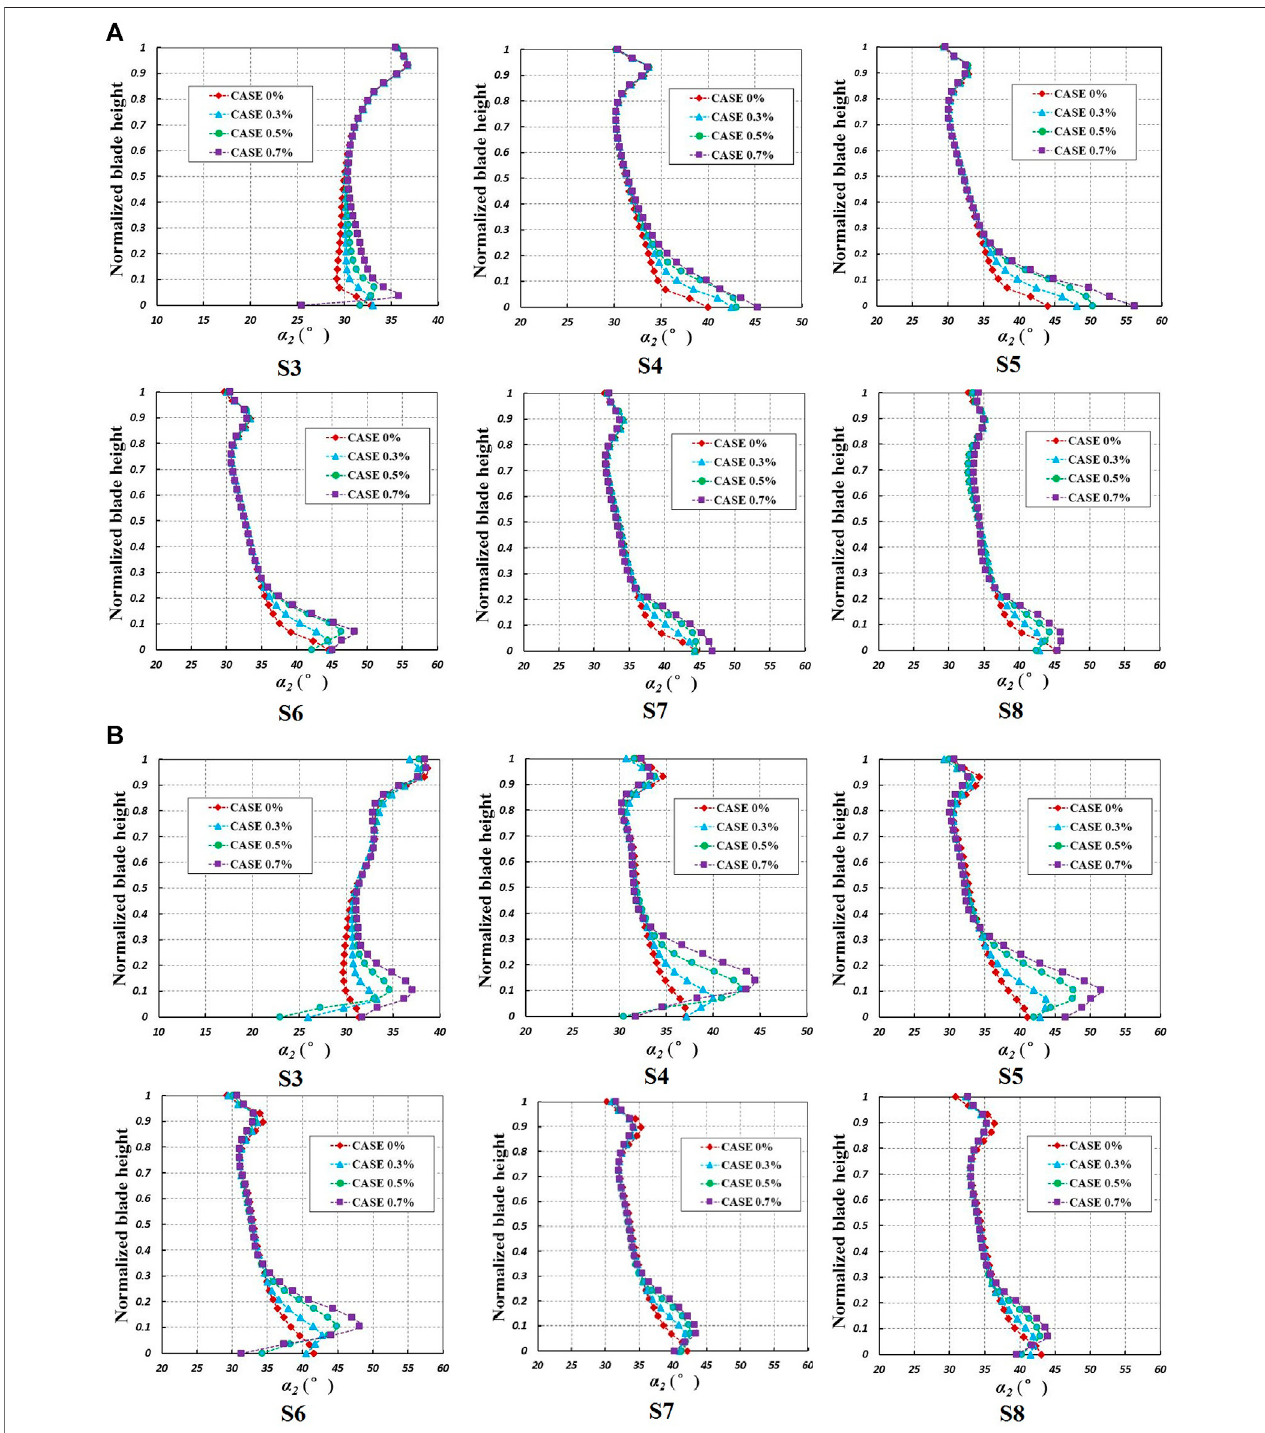
FIGURE 10 | Distribution of α 2 at each stator along its span at the design point of 100%n (A) , The nearest stall point of 75%n (B) .